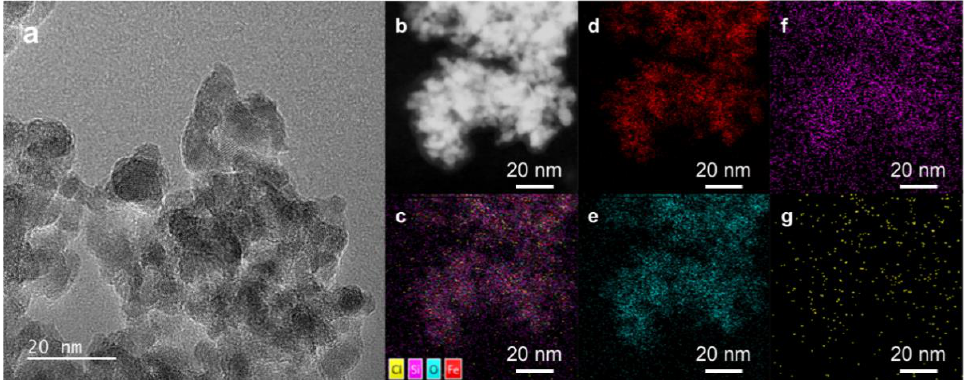
Figure 1. ( a ) TEM image, ( b ) HAADF-STEM image, and ( c – g ) STEM-EDS mapping images of freshly